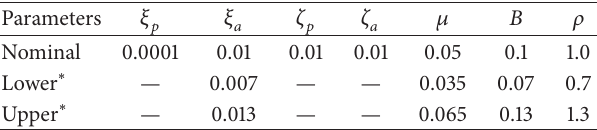
Table 2: Parameters used for the design of the nDVA.